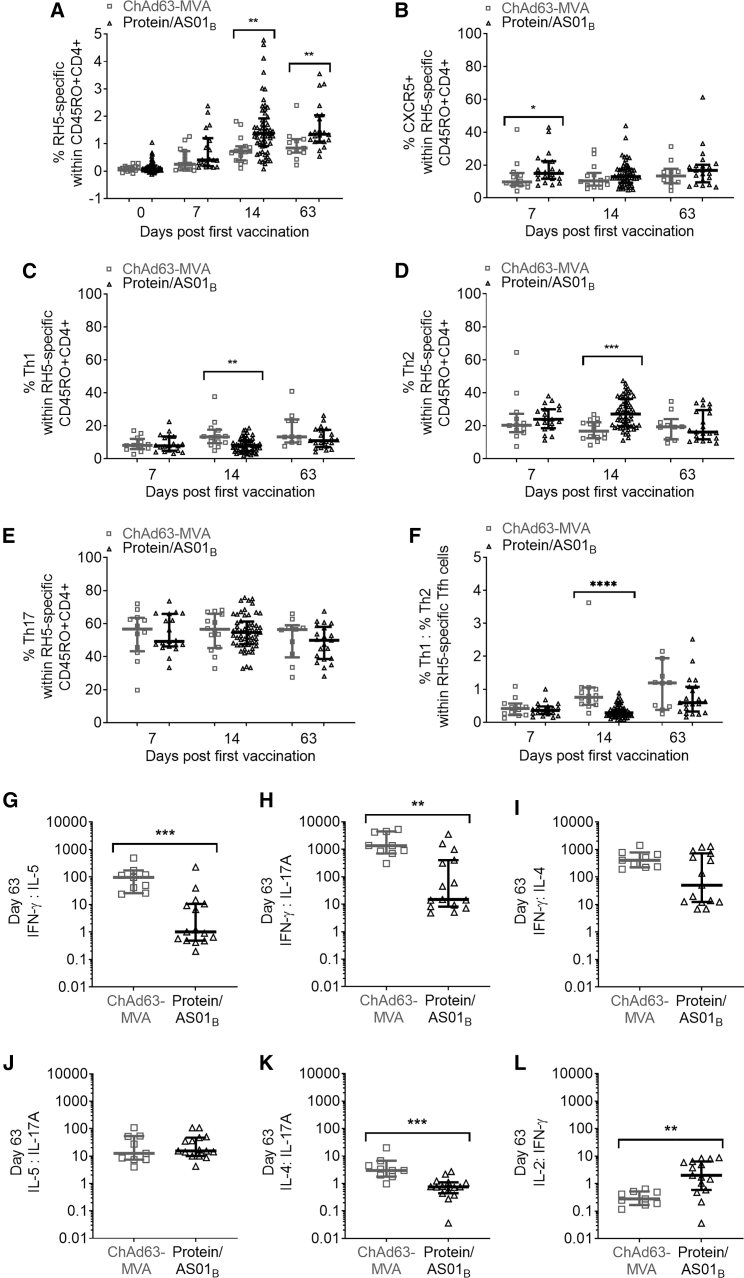
Protein/AS01B platform induces a more robust and Th2-skewed PfRH5-specific CD4+ response than ChAd63-MVA vaccinationPBMCs from days 0, 7, 14, and 63 were stimulated with medium alone or a PfRH5 peptide pool for 24 h, then stained and analyzed, identifying PfRH5-specific cells as those co-expressing CD25 with OX40, CD137, or CD69 following stimulation. Frequencies of CXCR5+ (cTfh cells), Th1 (CXCR3+CCR6−), Th2 (CXCR3−CCR6−), and Th17 (CXCR3−CCR6+) were also quantified within RH5-specific CD4+CD45RO+ cells (all gating as in Figure S4).(A) Frequencies of PfRH5-specific cells within CD45RO+CD4+ T cells were compared between each time point between trials.(B–F) Within the PfRH5-specific CD45RO+CD4+ T cell population, the proportion of cells that were CXCR5+ cTfh (B), CXCR3+CCR6− (Th1) (C), CXCR3−CCR6− (Th2) (D), CXCR3−CCR6+ (Th17) (E), or the ratio of Th1:Th2 cells (F) was also compared between platforms at each time point.(G–L) A multiplex bead-based assay was then used to measure the supernatant concentrations of cytokines, and the Th1/Th2/Th17 skew of the cytokine response was determined by calculating ratios of IFN-γ:IL-5 (G), IFN-γ:IL-17A (H), IFN-γ:IL-4 (I), IL-5-IL-17A (J), IL-4:IL-17A (K), and IL-2:IFN-γ (L) in supernatants from day 63 PBMCs.In (A), all of the available samples were analyzed (ChAd63-MVA/protein/AS01B): day 0, n = 15/57; day 7, n = 15/20; day 14, n = 15/57; and day 63, n = 11/22. In (B–F), samples were excluded if the total number of PfRH5-specific CD45RO+CD4+ T cells was <50 (ChAd63-MVA/protein/AS01B): day 7, n = 12/20; day 14, n = 14/56; and day 63, n = 10/21. A multiplex assay (G–L) was run on a subset of samples (ChAd63-MVA/protein/AS01B): day 63, n = 9/15. Comparisons between trials were performed using Mann-Whitney tests. ∗p < 0.05, ∗∗p < 0.01, ∗∗∗p < 0.001, and ∗∗∗∗p < 0.0001. In all of the panels, each point represents a vaccinee. Lines denote medians and interquartile ranges.